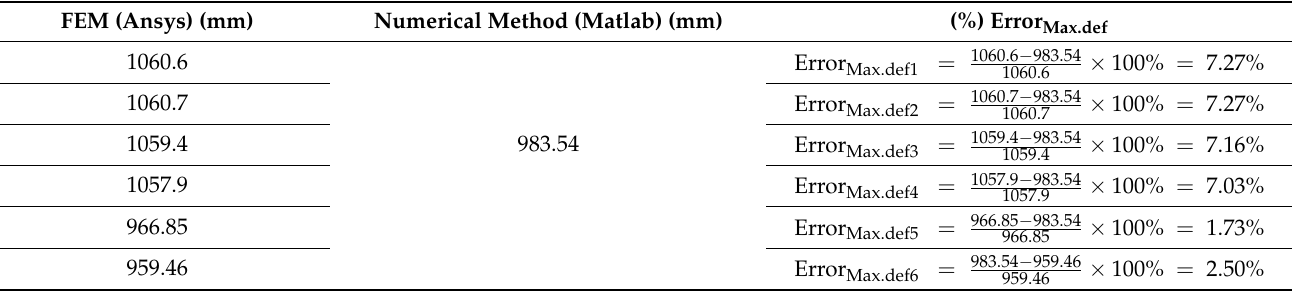
Table 4. Values of maximum deformation by FEM and numerical